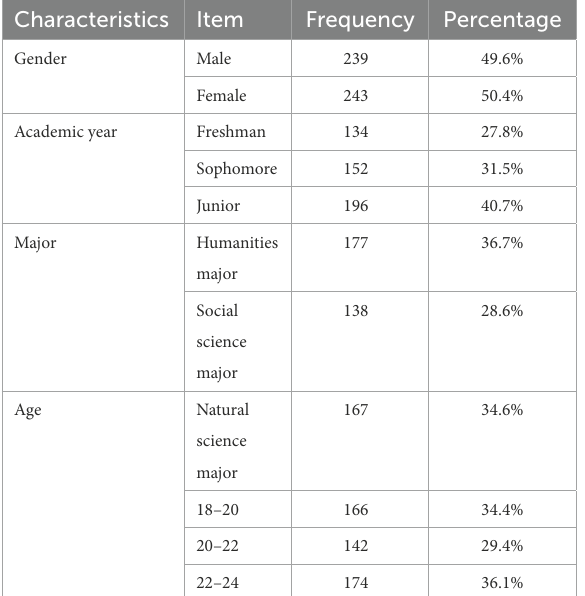
TABLE 1 Demographic information of the